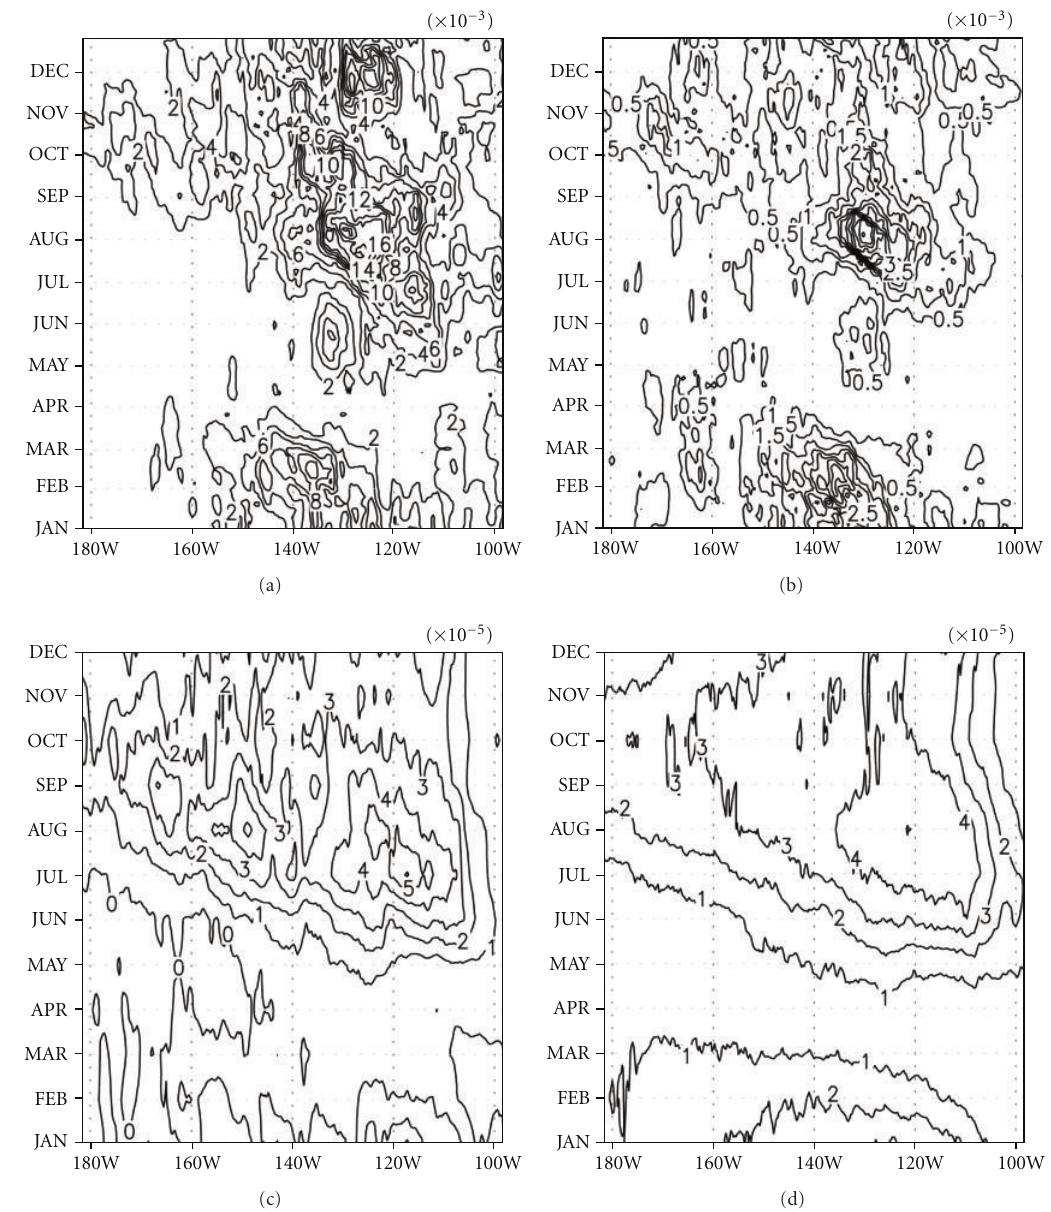
Figure 5: Longitude-time plot of the climatological cycle of the 30-day moving variance of filtered temperature (a) and meridional current (b), and barotropic (c) and baroclinic (d) conversion rates averaged between 0 and 5 ◦ N over the upper 50 m. Units are W/m 3 for (c) and